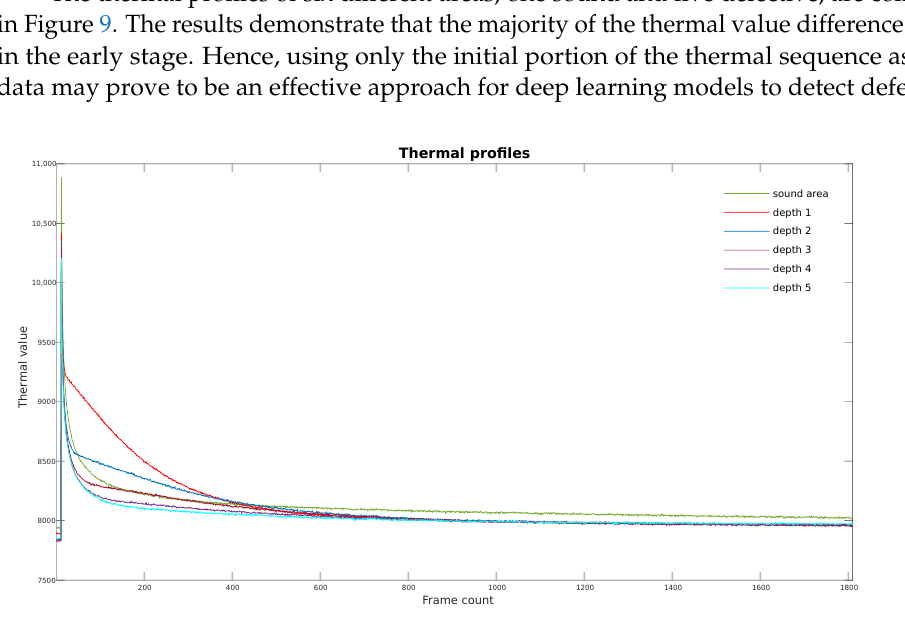
Figure 9. Thermal profiles comparison from sound area and defective areas with different defect